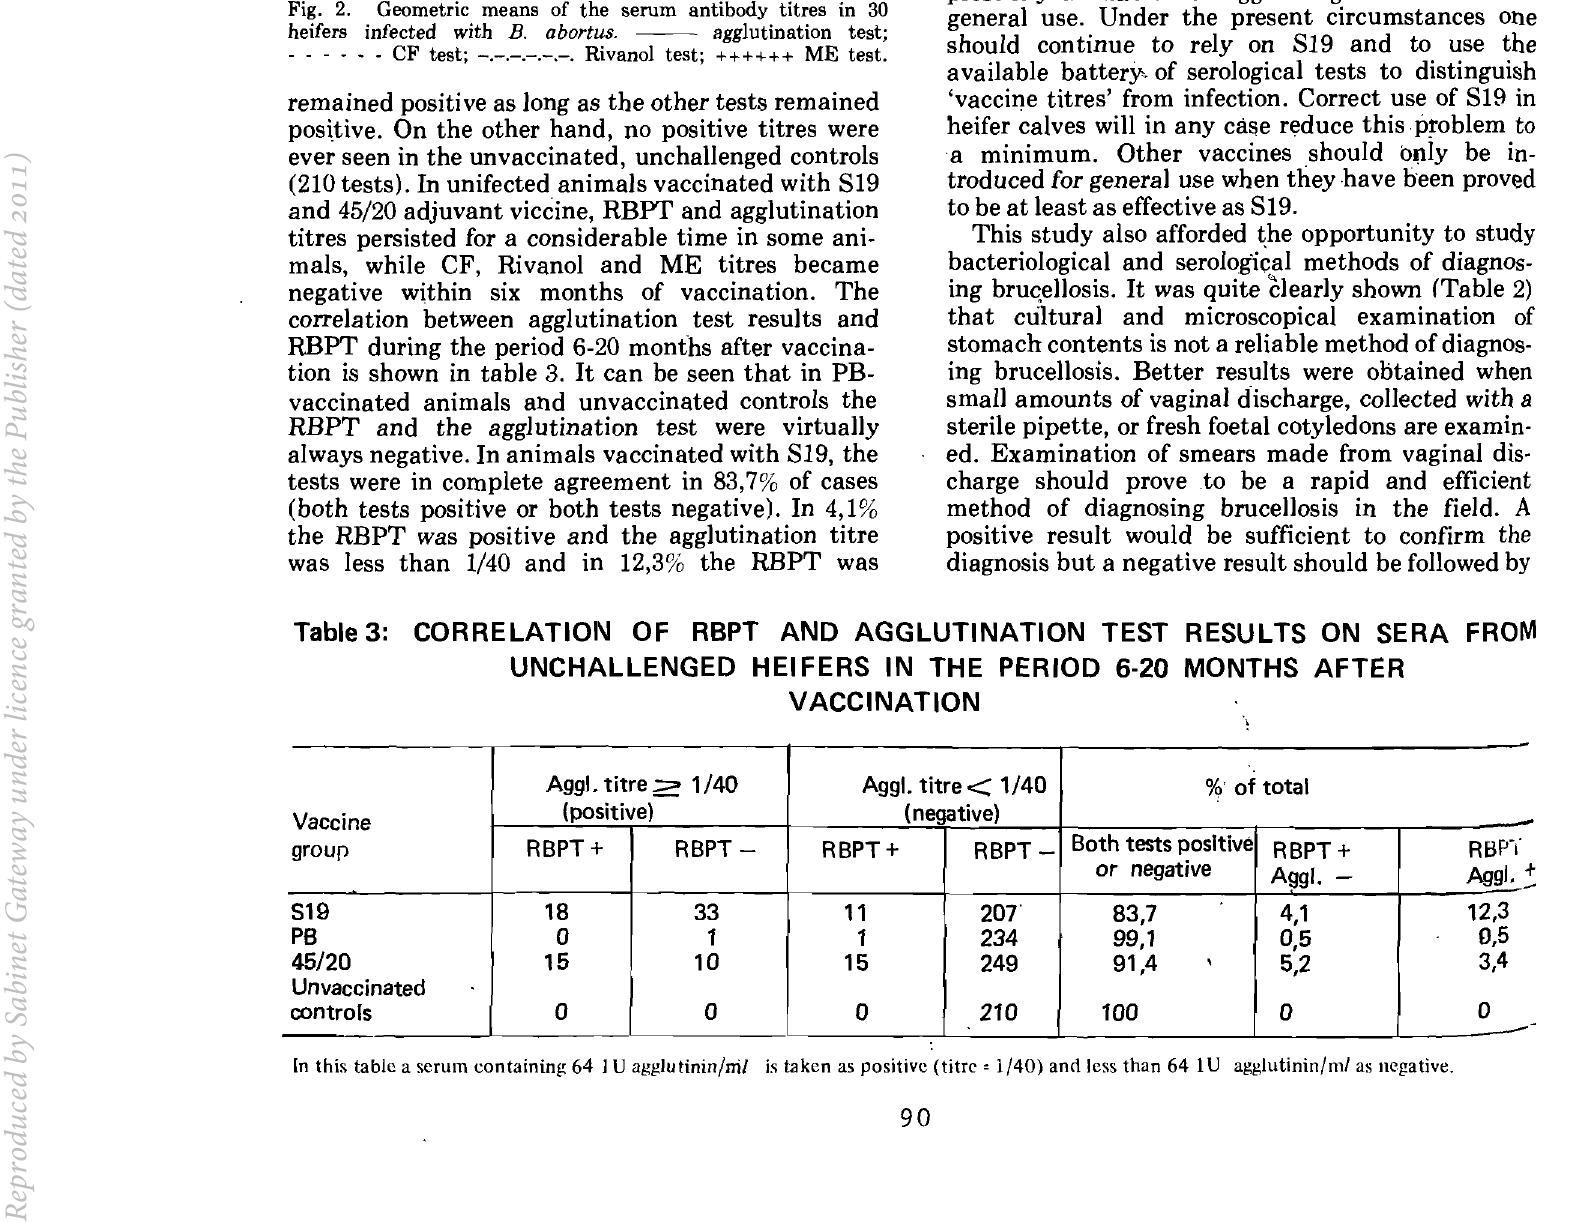
Geometric means of the serum antibody titres in 30 heifers infected with B. abortus. - - agglutination test; - - - - - - CF test; -.-.-.-.-.-. Rivanol test; ++++++ ME test.